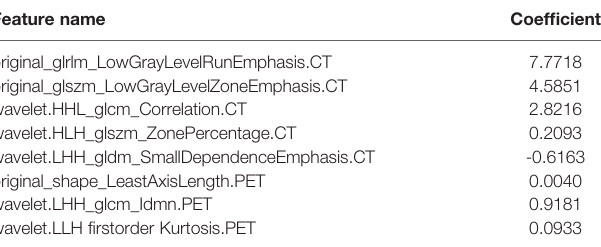
TABLE 3 | Radiomic characteristics and signi fi cance of PET/CT radiomic scores (Rad-scores) used to calculate OS. Feature name